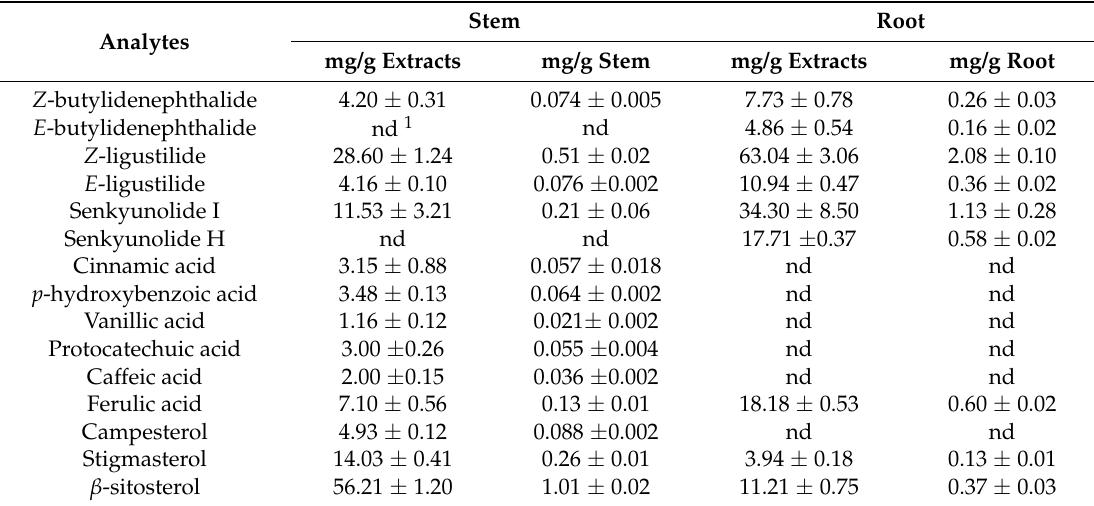
Table 2. Contents of 15 components in AS stem and root revealed by